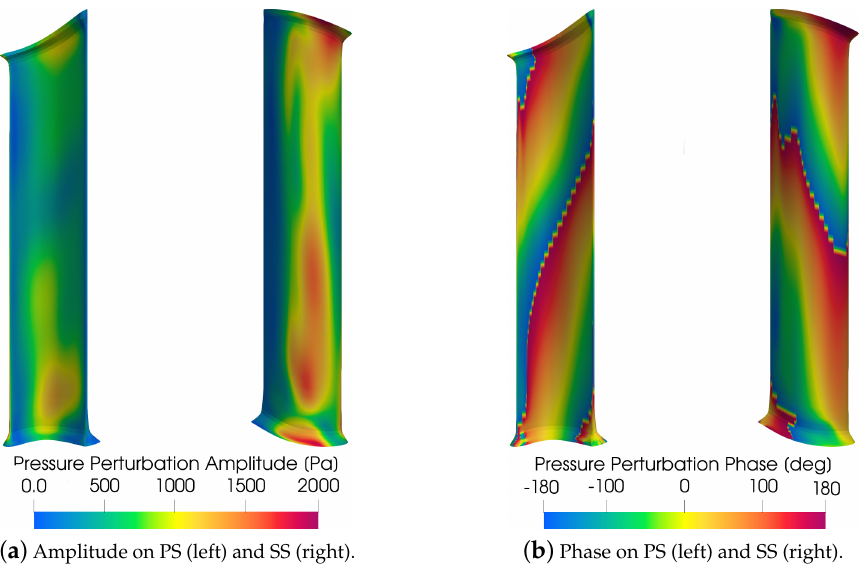
( a ) Amplitude on PS (left) and SS (right). ( b ) Phase on PS (left) and SS (right). Figure 12. Unsteady forcing at EO = 126 and ND = +